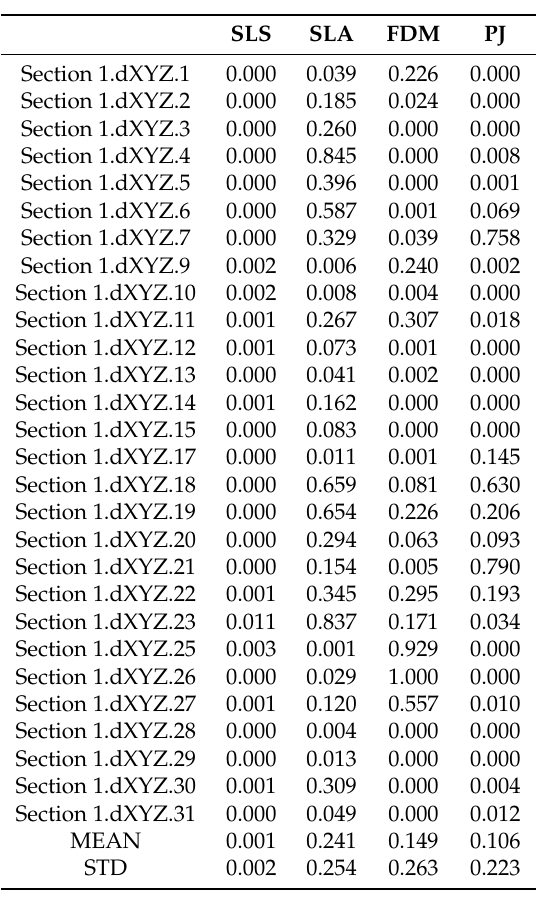
Table 1. Standard deviations of printed models from the nominal model created by individual printing methods (technologies) for 31 sectional